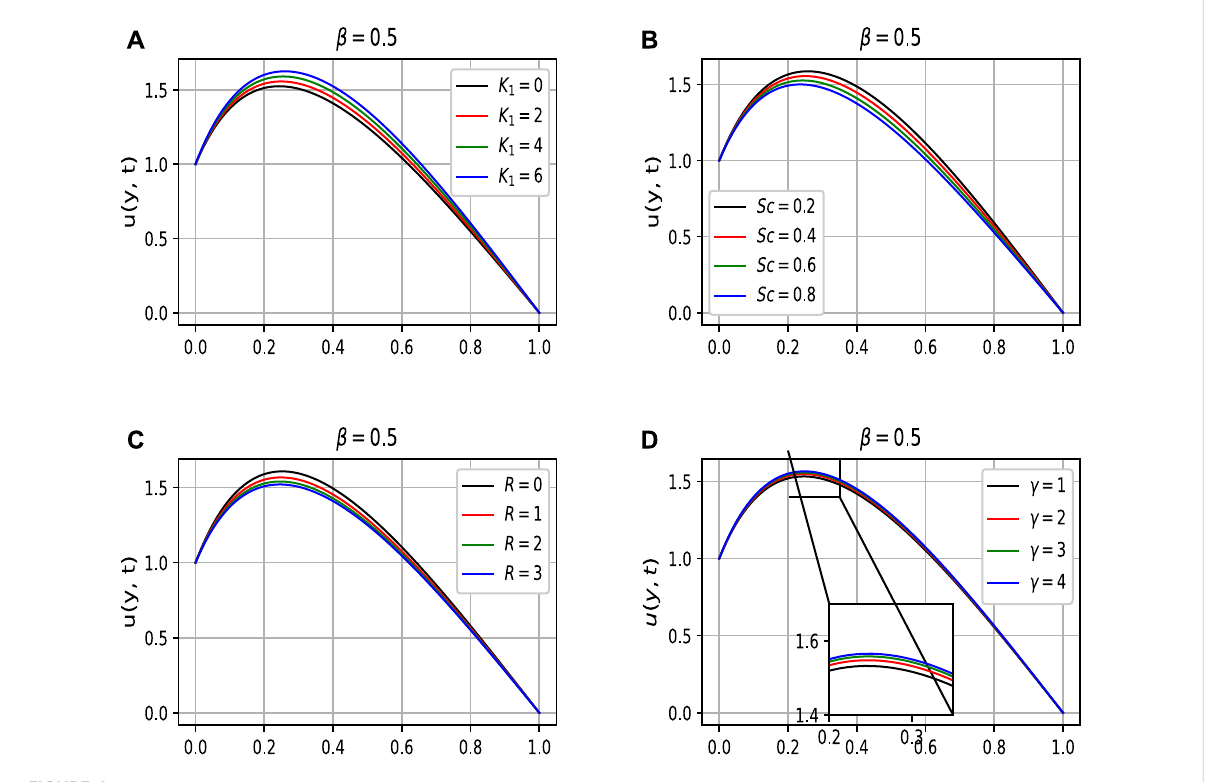
FIGURE 4 The behaviour of the boundary layer velocity as the parameters K 1 , Sc , R and γ vary.